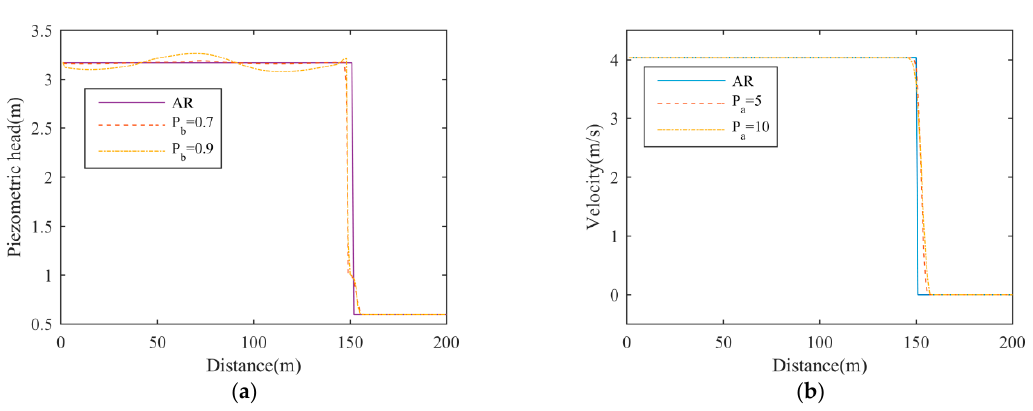
Figure 14. Comparison of the results simulated by P_HLL, with P a = 5 and P b = 0.7 or P b = 0.9, and the analytical result (AR): ( a ) piezometric head; ( b ) flow velocity.